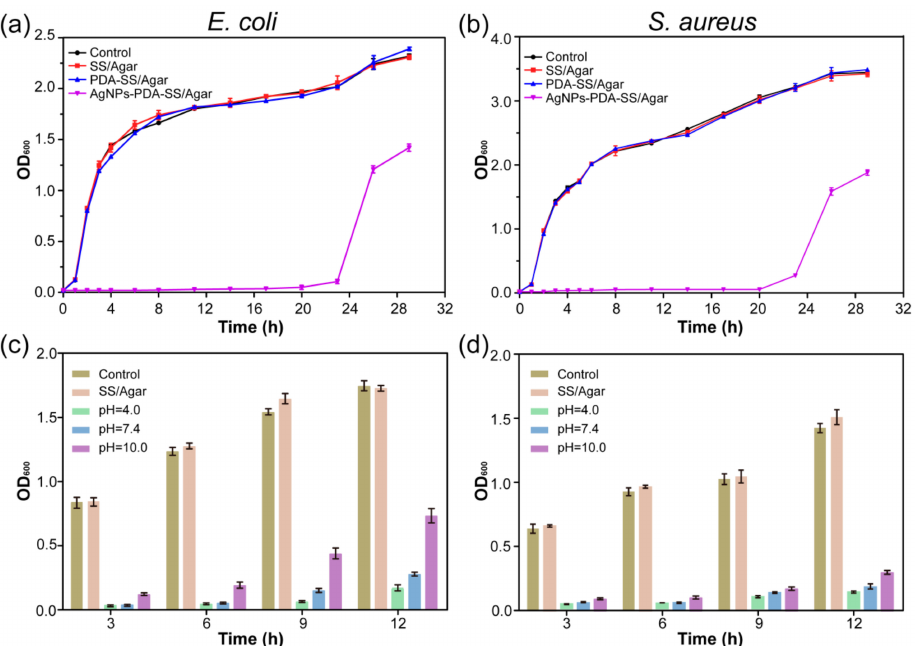
Figure 8. Bacterial growth curve of E. coli ( a ) and S. aureus ( b ) in the presence of different films, and antimicrobial stability analysis of AgNPs-PDA-SS/Agar film under different pH conditions ( c , d ).